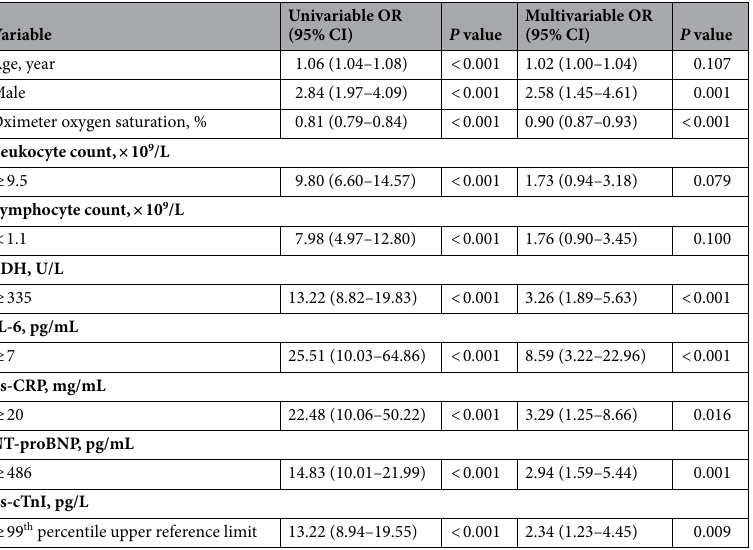
Table 3. Univariate and multivariate regression analyses of risk factors associated with in-hospital mortality. LDH, lactate dehydrogenase; IL-6,